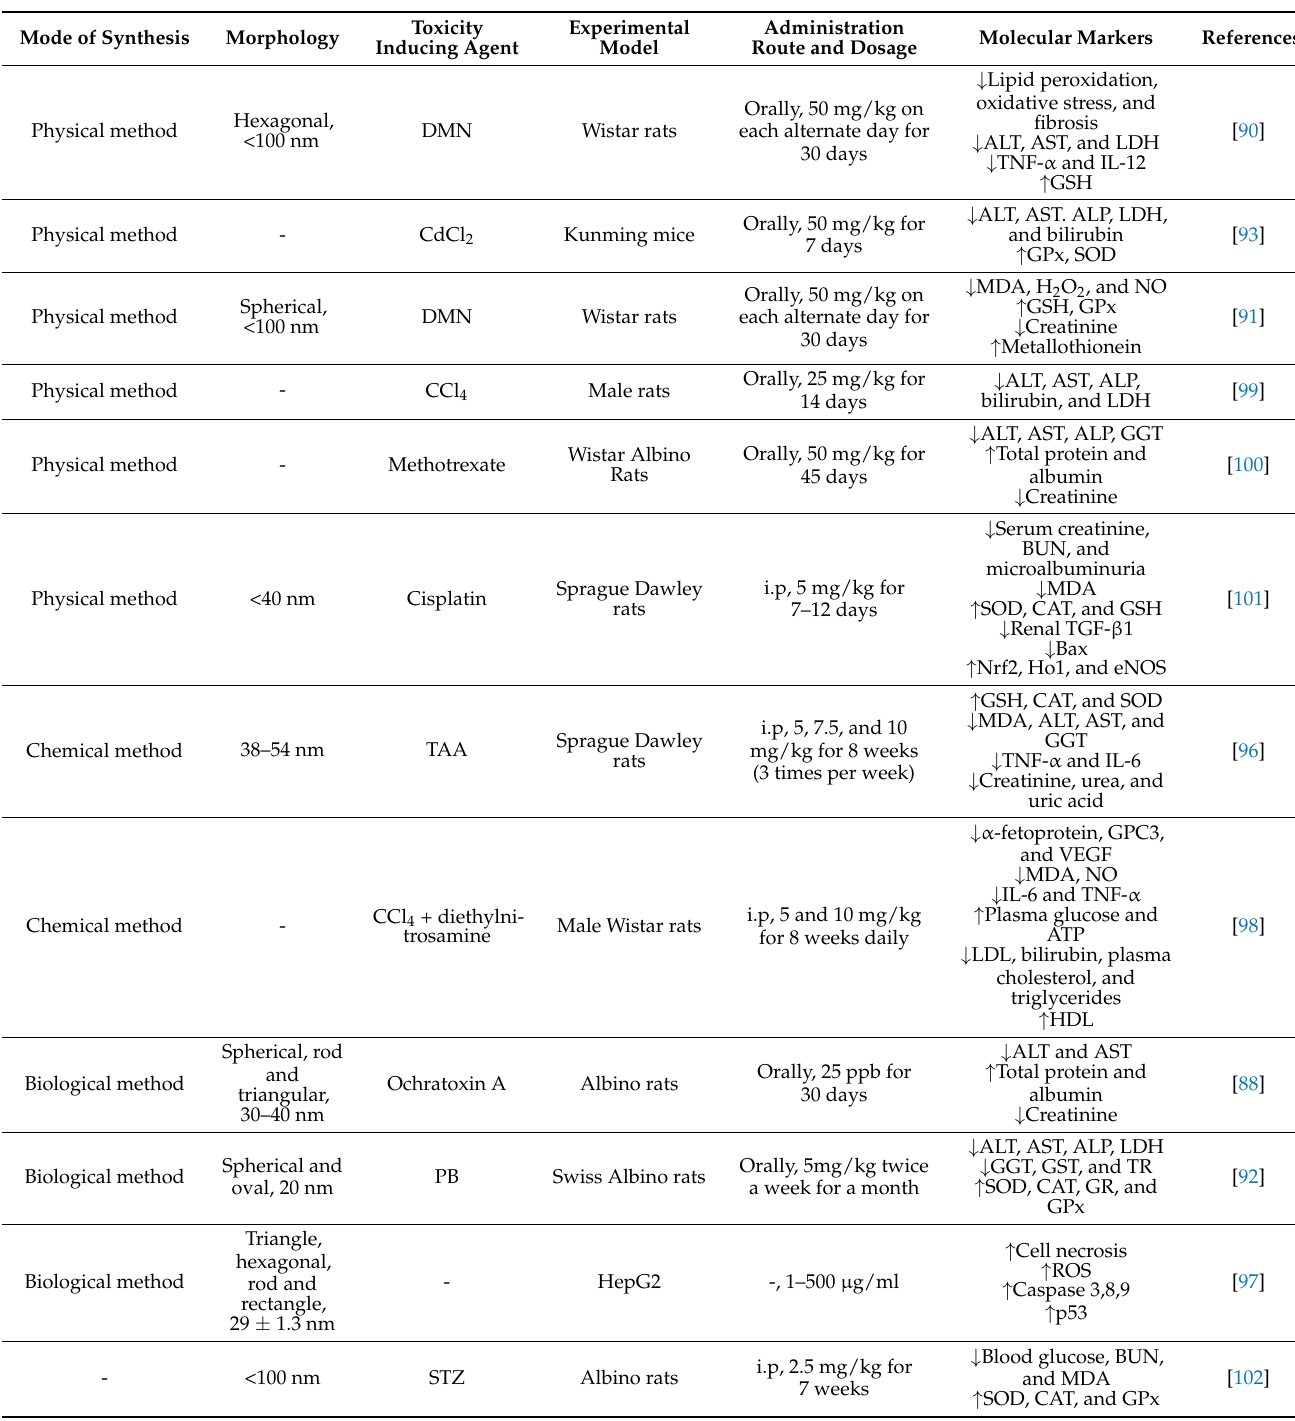
Table 2. Summary of the ameliorative effects of ZnONPs against hepato-renal